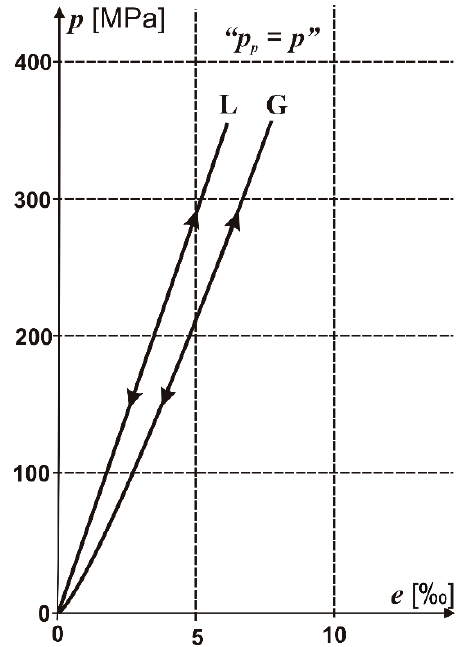
Figure 3. Compressibility curves “ p p = p ”: L—material without isolated cracks (limestone from stone pit Morawica), G—material with isolated cracks (granite from stone pit Strzelin); reproduced from [10], Arch. Min. Sci.: 1989.